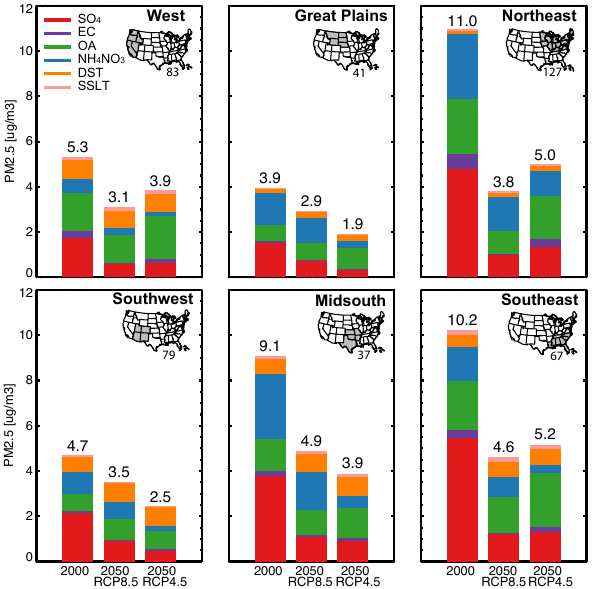
Figure 7. Annual PM 2 . 5 chemical species for present-day and 2050 as predicted by the RCP4.5 and RCP8.5 scenarios in the US climatic regions. The inset maps show the states in the region in gray, and the numerals indicate the numbers of US national parks and wilder- ness areas in each climatic region. Big numerals indicate the annual PM 2 . 5 concentrations. Figure 8. Changes in PM 2 . 5 resulting from climate-driven fire ac- tivity in the US regions affected by fire. Simulated PM 2 . 5 by the RCP scenarios is shown in gray and future PM 2 . 5 from climate- driven fire emissions in red. The inset maps show the states in the region in gray and the red numerals indicate the percentage change in PM 2 . 5 when climate-driven fire activity is included in the simu- lation.